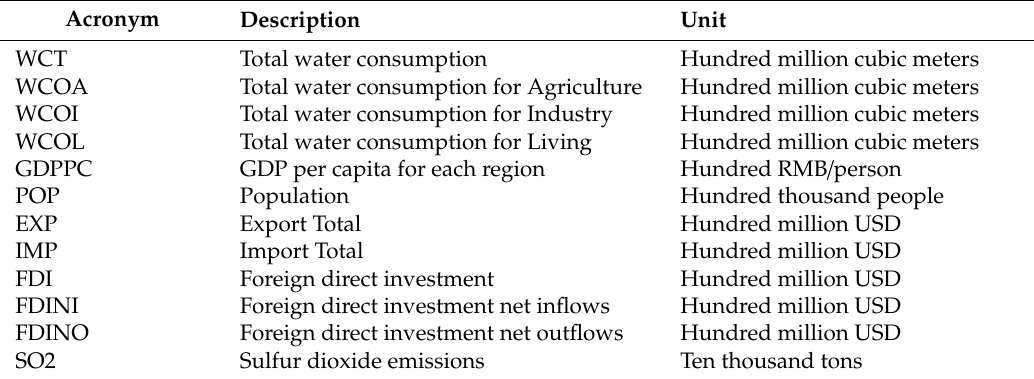
Table 2. Definitions of the variables.